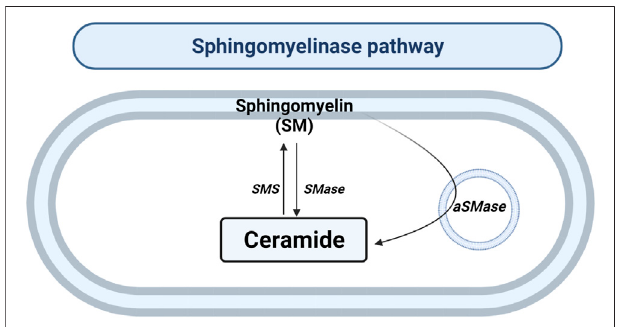
FIGURE 3 | Sphingomyelinase pathway. Solid arrows represent single reactions. Sphingomyelinase (SMase), acid sphingomyelinase (aSMase) and sphingomyelin synthase (SMS) are represented by their